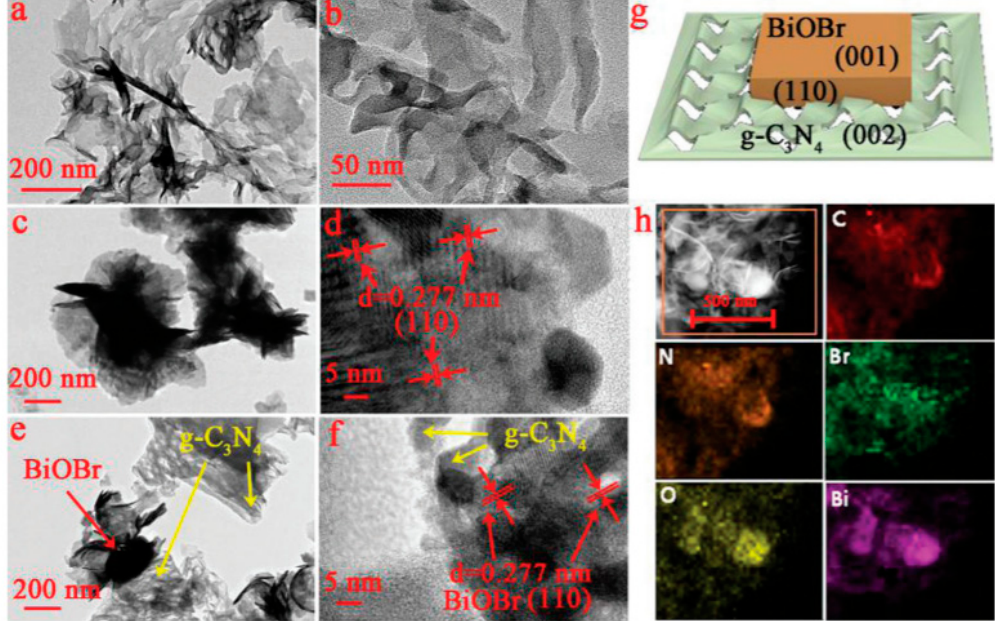
Figure 5. TEM micrographs of ( a , b ) pristine g-C 3 N 4 , ( c , d ) pristine BiOBr and ( e , f ) g-C 3 N 4 /BiOBr; ( g ) schematic representa- tion of growth of BiOBr layer over the surface of g-C 3 N 4 forming the heterojunction photocatalyst and ( h ) elemental maps confirming the growth of BiOBr over g-C 3 N 4 . Reprinted from Ref. [99] with permission from The Royal Society of Chem- istry.